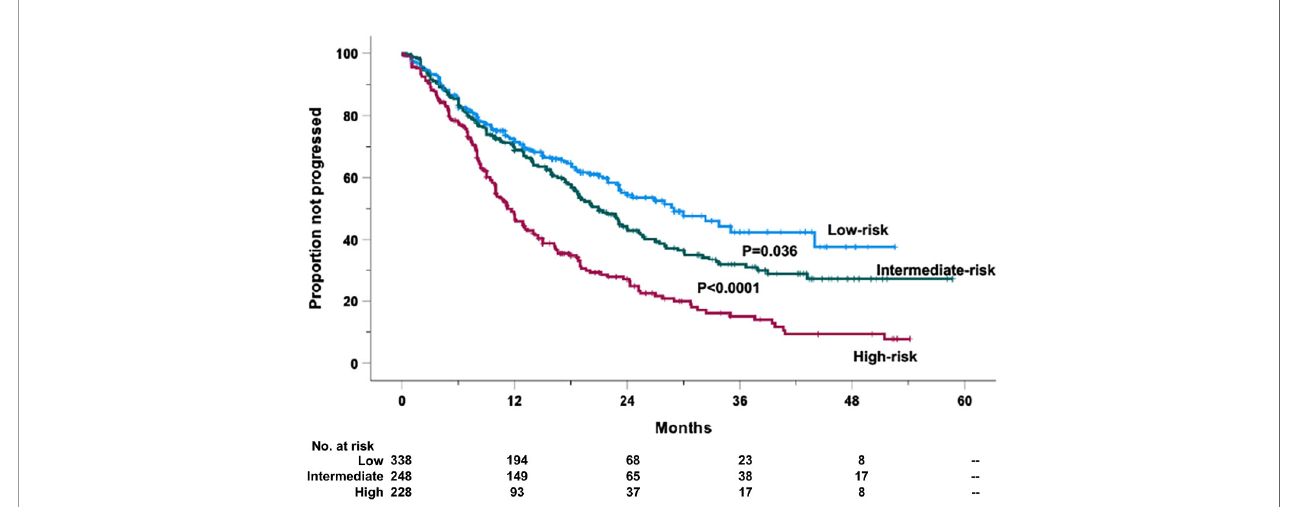
FIGURE 2 | Progression-free survival (PFS) of the retrospective relapsed/refractory (RR) multiple myeloma cases treated with KRd or EloRd clustered in low- (1st and 2nd quartiles, 338 cases), intermediate- (2nd – 3rd quartiles, 248 cases), high-risk categories (4th quartile, 228 cases), by the four-factor risk model. This analysis was carried out in 814 cases treated with KRd (559 cases) or EloRd (255 cases) in which all the fi ve variables were